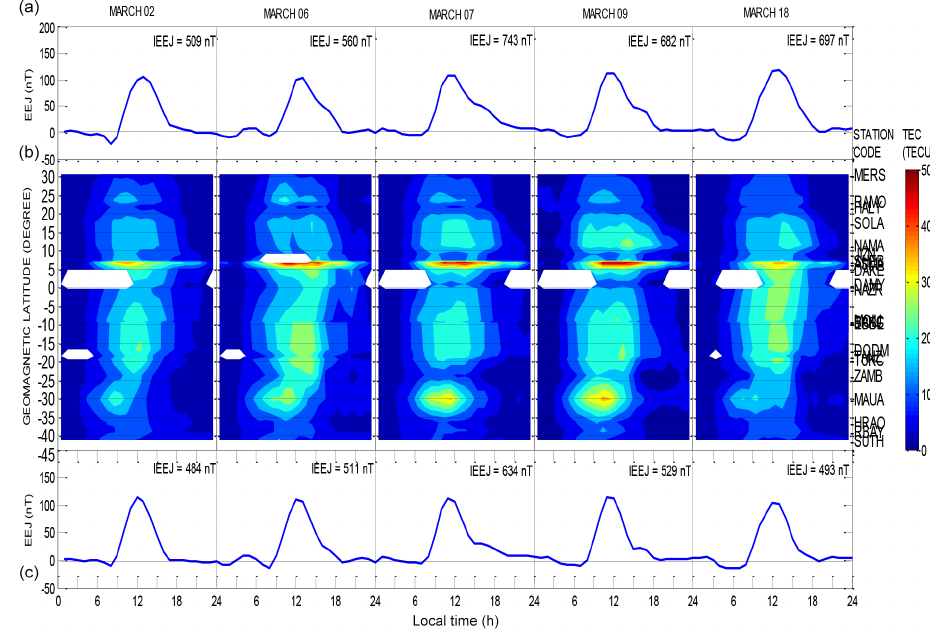
Figure 4. The TEC magnitudes of the quietest days, equatorial electrojet (EEJ) strength, and integrated EEJ strength in March.